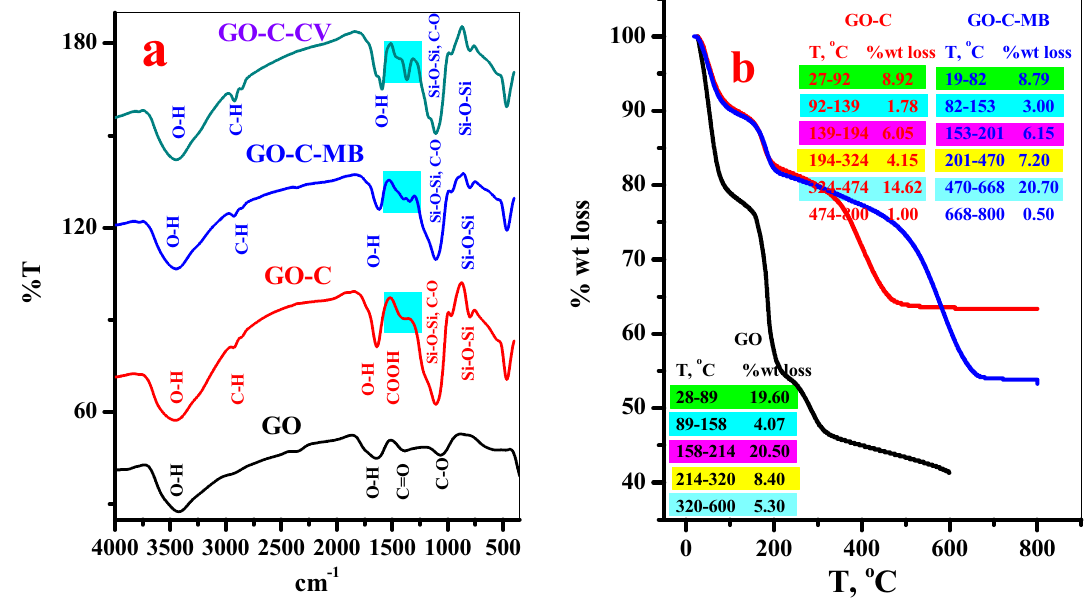
Figure 3. ( a ) FT-IR spectraGO, GO–C composite, GO–C–MB complex and GO–C–CV complex and ( b ) TGA diagram of GO, GO–C composite and GO–C–MB